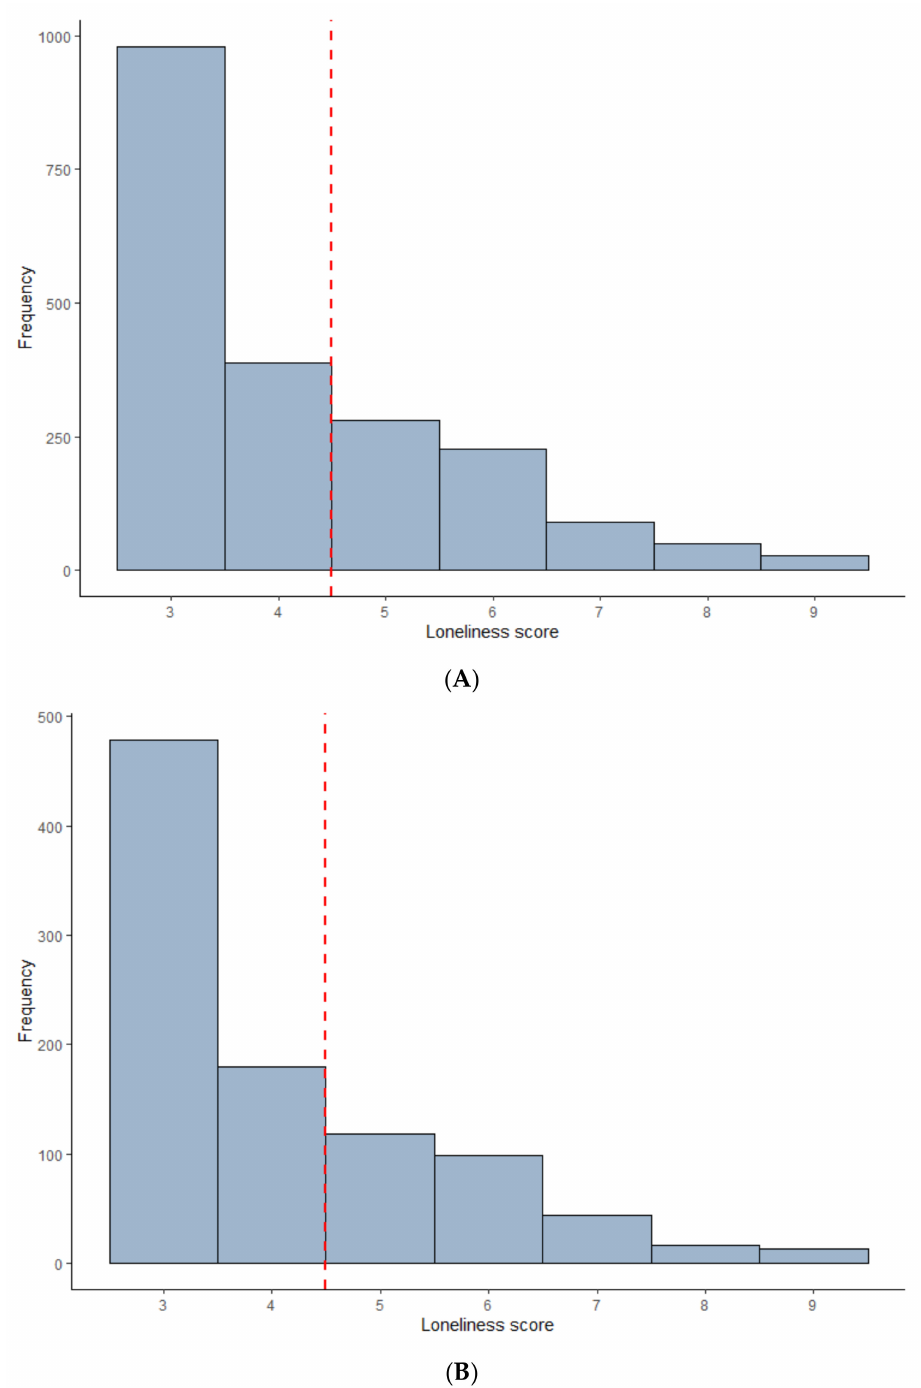
Figure 2. Histograms of 3-item UCLA Loneliness Scale scores, with hypothetical cut-off score of 5 applied. ( A ) Age-18 sample. ( B ) Age-38